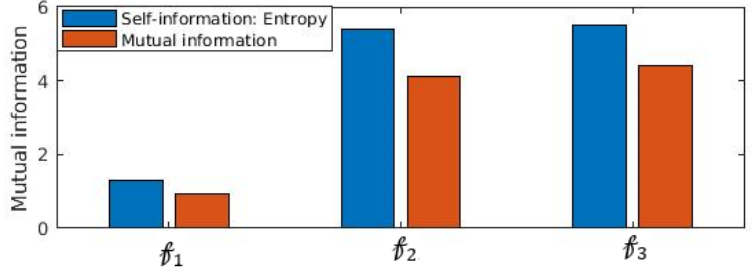
test respectively. We observe F test and privacy